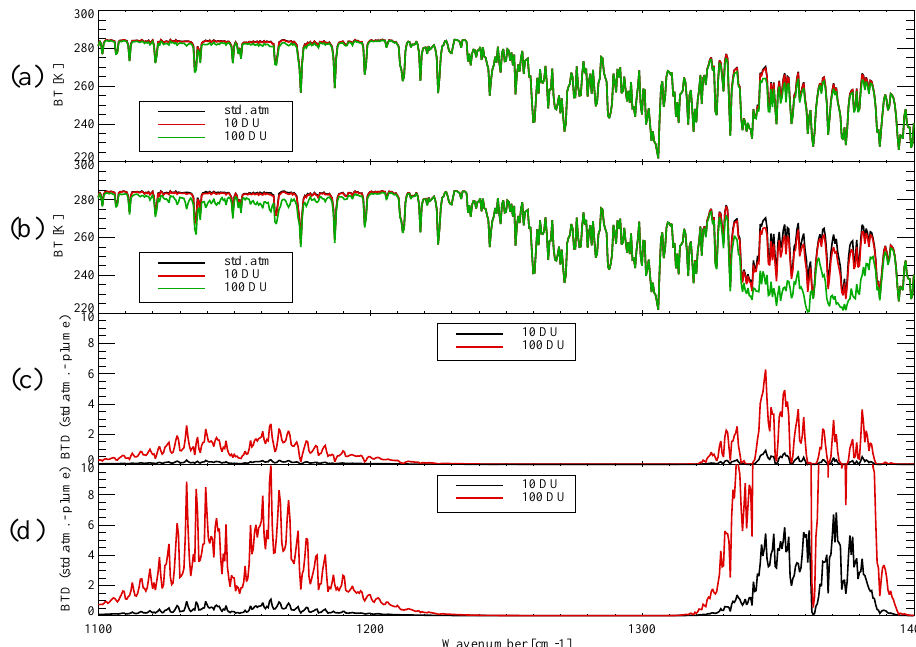
Fig. 2. (a) Simulated IASI spectra brightness temperature spectra for (i) the reference clear atmosphere (black line) (ii) the reference clear atmosphere with the addition of a tropospheric SO 2 plume between 1 and 5km containing a total column amount of 10DU (red line) or 100DU (green line) of SO 2 ; (b) Simulated IASI spectra brightness temperature spectra for (i) the reference clear atmosphere (black line) (ii) the reference clear atmosphere with the addition of a stratospheric SO 2 plume between 9 and 14km containing a total column amount of 10DU (red line) or 100DU (green line) of SO 2 ; (c) Brightness temperature differences ( 1T B ) between the the reference clear atmosphere and the reference clear atmosphere enhanced by a tropospheric SO 2 plume containing a total column amount of 10DU (black line) or 100DU (red line) of SO 2 ; (d) Brightness temperature differences ( 1T B ) between the reference clear atmosphere and the reference clear atmosphere enhanced by a stratospheric SO 2 plume containing a total column amount of 10DU (black line) or 100DU (red line) of SO 2